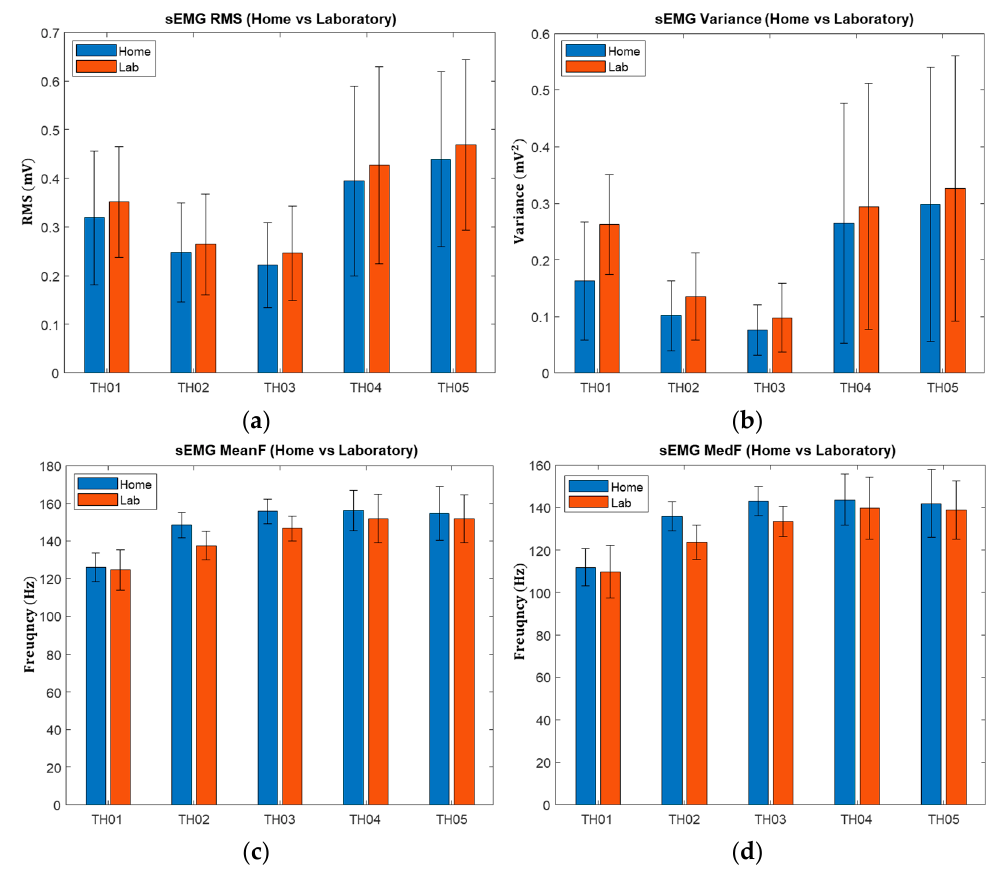
Figure 1. An example of TH02 ′ s calibration data with all seven motions ( a ) at home and ( b ) in a laboratory setting. The red vertical lines separate different motions.